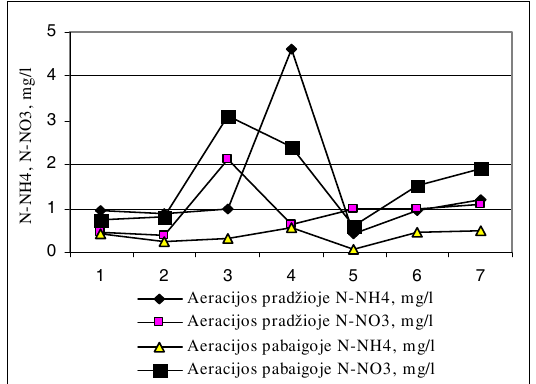
Fig 12. Concentration change of ammonium nitrogen and nitrates in the second aeration tank in the beginning and at the end of aeration at aeration rate of 150 min, and redu- ced aeration rate of 180 min